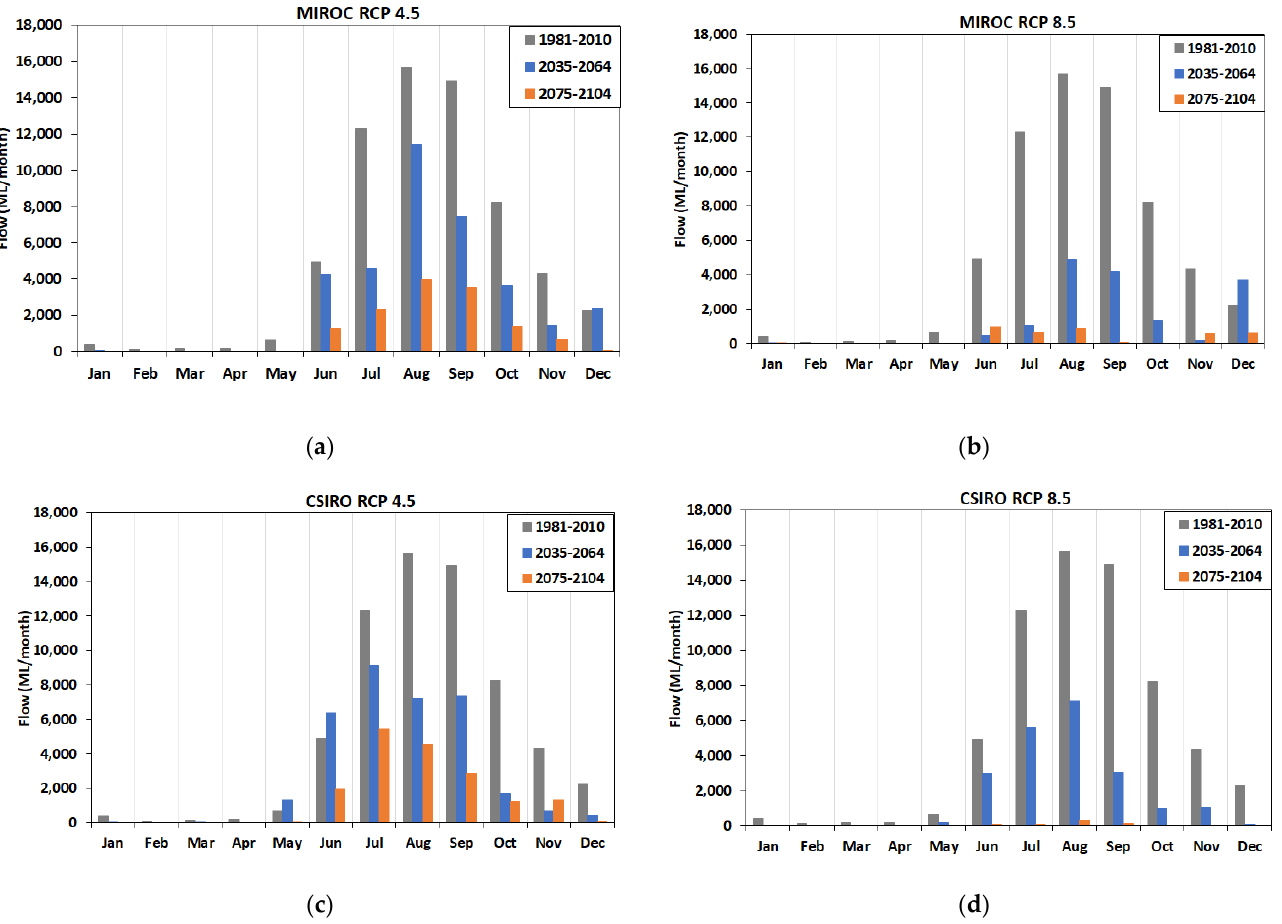
Figure 6. Observed and projected monthly streamflow: ( a ) MIROC-RCP4.5 model; ( b ) MIROC-RCP8.5 model; ( c ) CSIRO- RCP4.5 model; ( d ) CSIRO-RCP8.5 model.